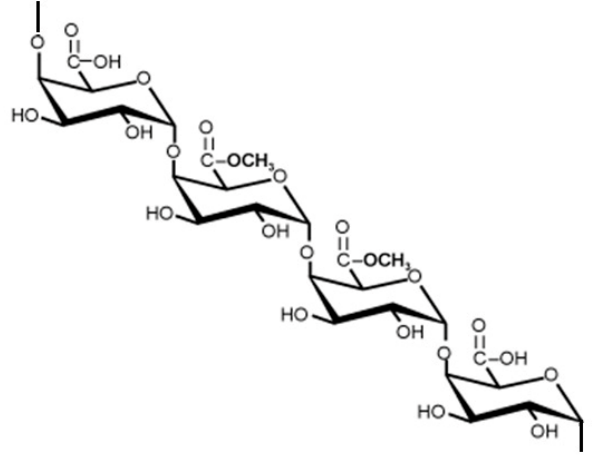
Figure 13. Schematic presentation of pectin [163].